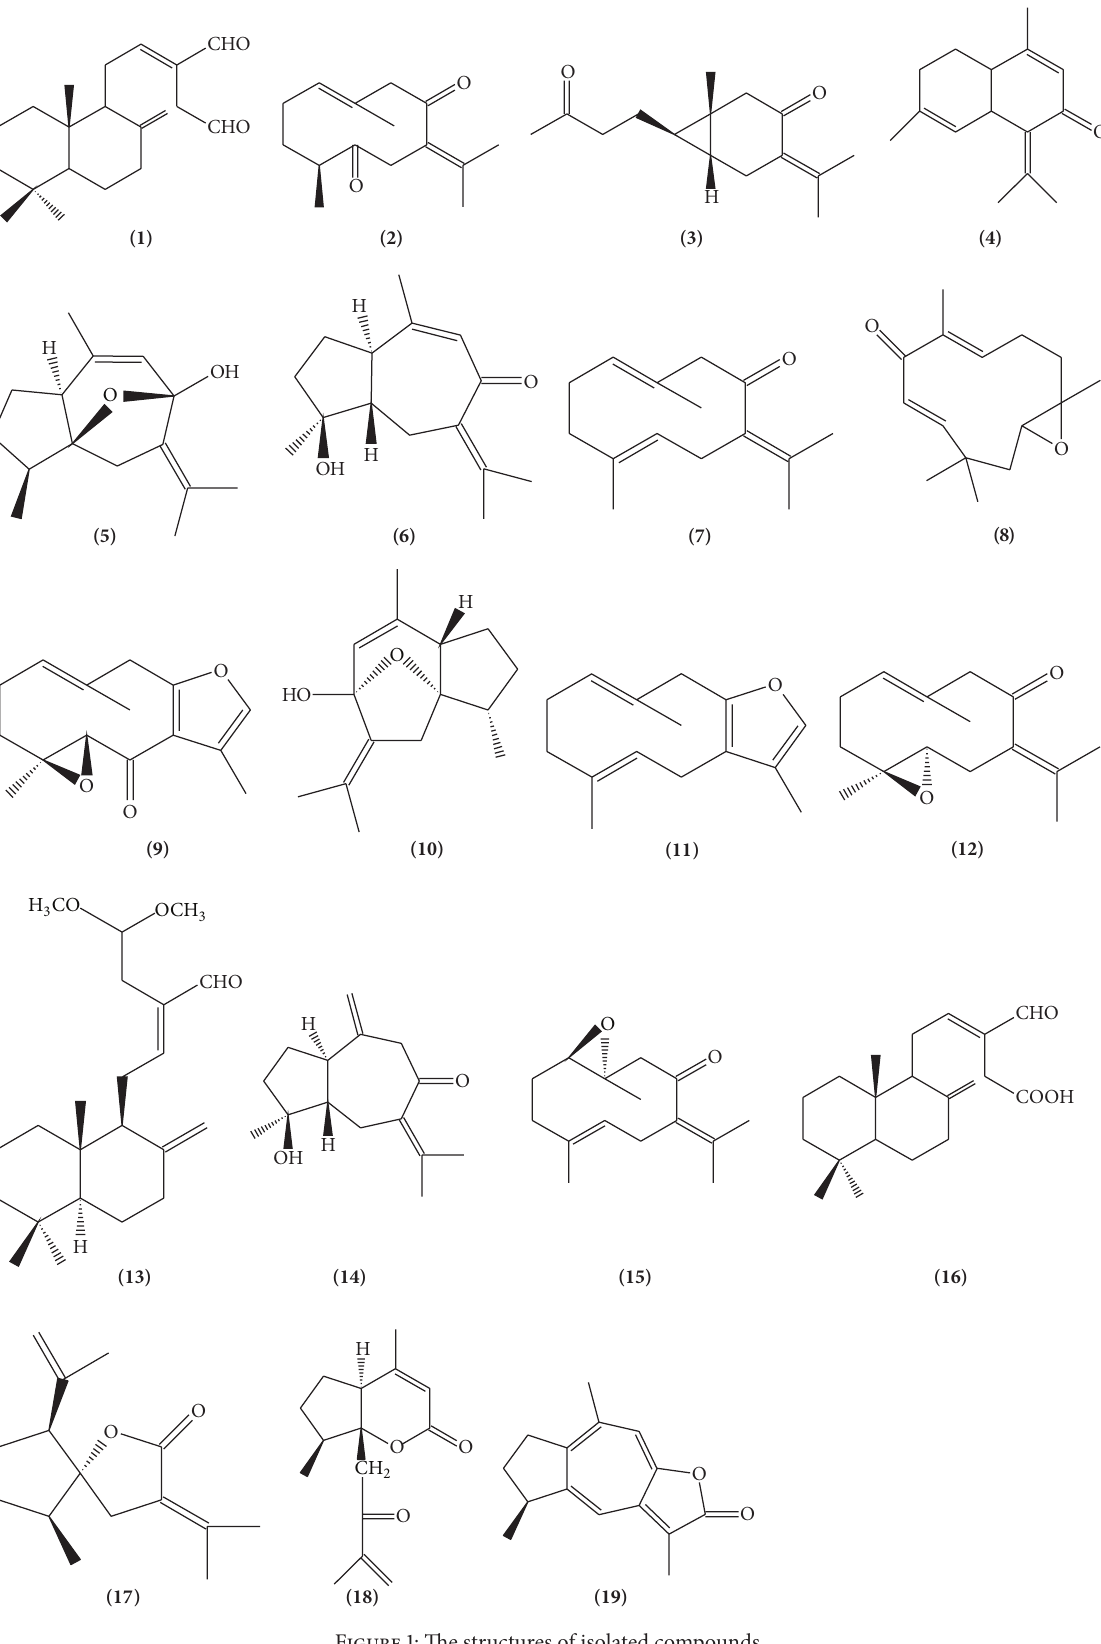
Figure 1: The structures of isolated